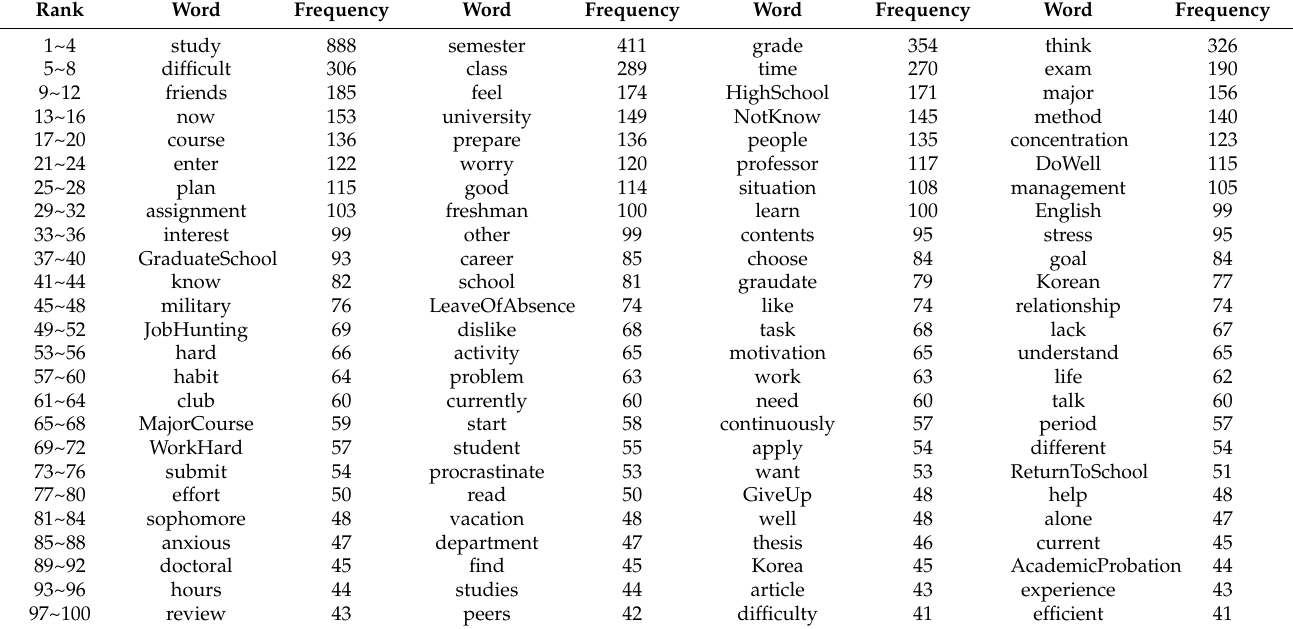
Table A2. Keywords in STEM track with frequency of 30 or